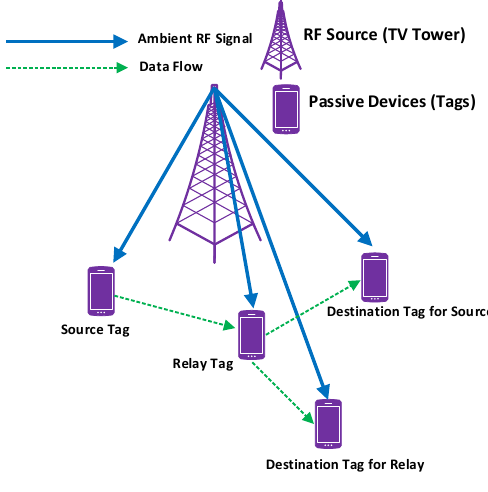
Figure 37. Relaying in